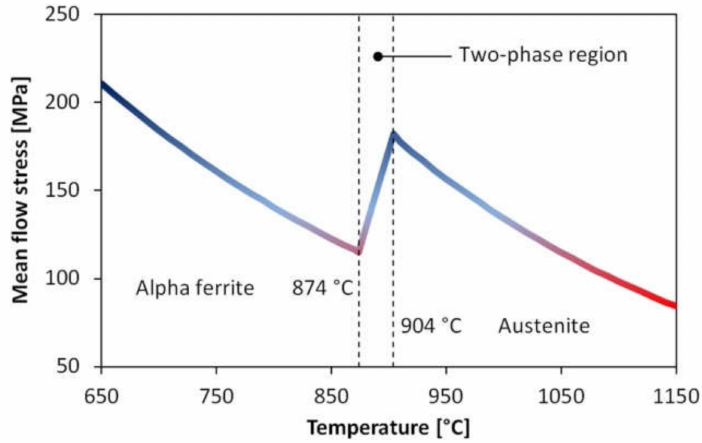
Figure 15. Influence of phase composition on mean flow stress of the Ti–IF